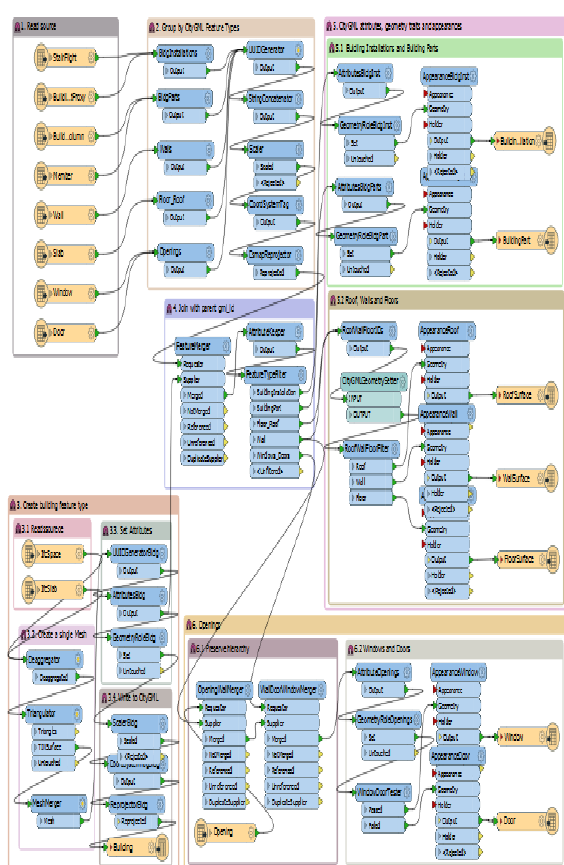
Figure 10. IFC to CityGML Transformation FME Workbench (Safe,